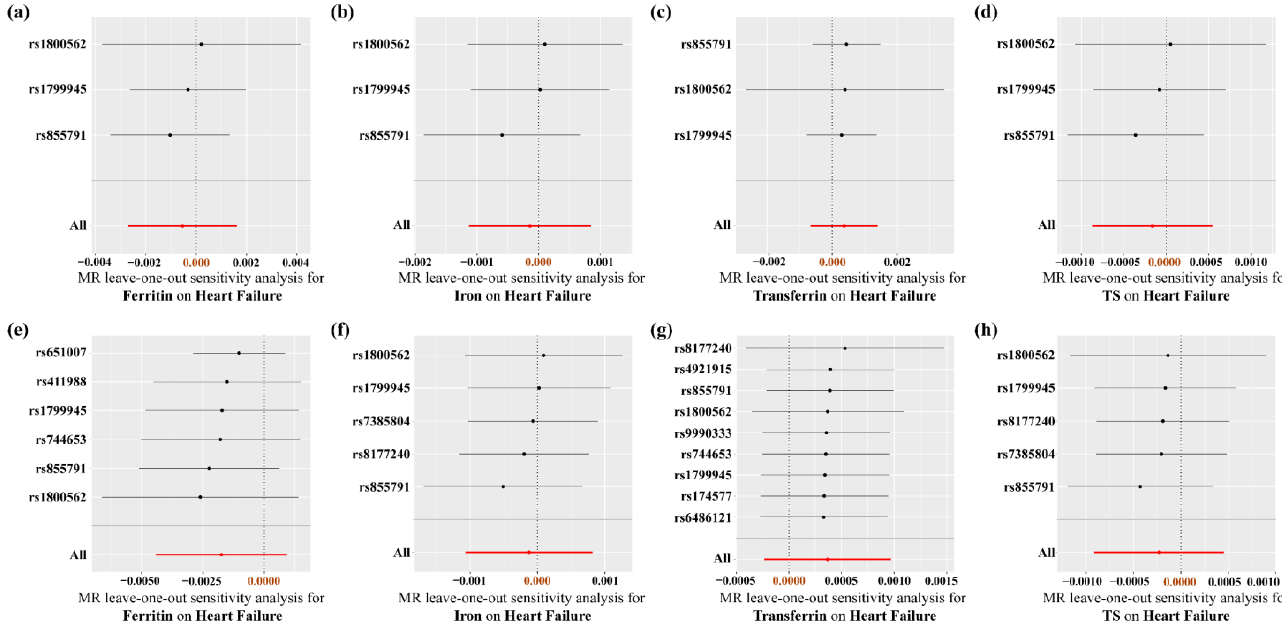
Figure 4. Leave-one-out analysis of the causal association between iron status and heart failure risk. ( a – d ) Using three SNPs associated with all four iron biomarkers; ( e – h ) using separately selected SNPs associated with each iron status biomarker.